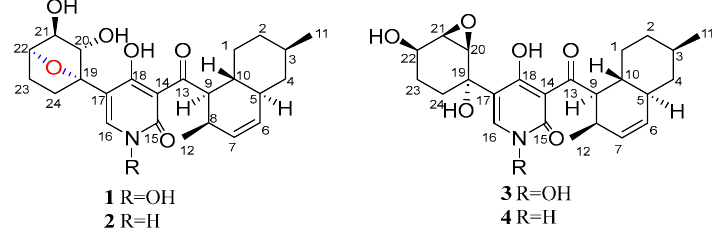
Figure 1. Structures of compounds 1 – 4